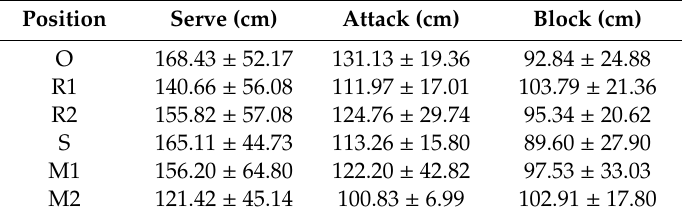
Table 2. Mean jump distance of elite volleyball players